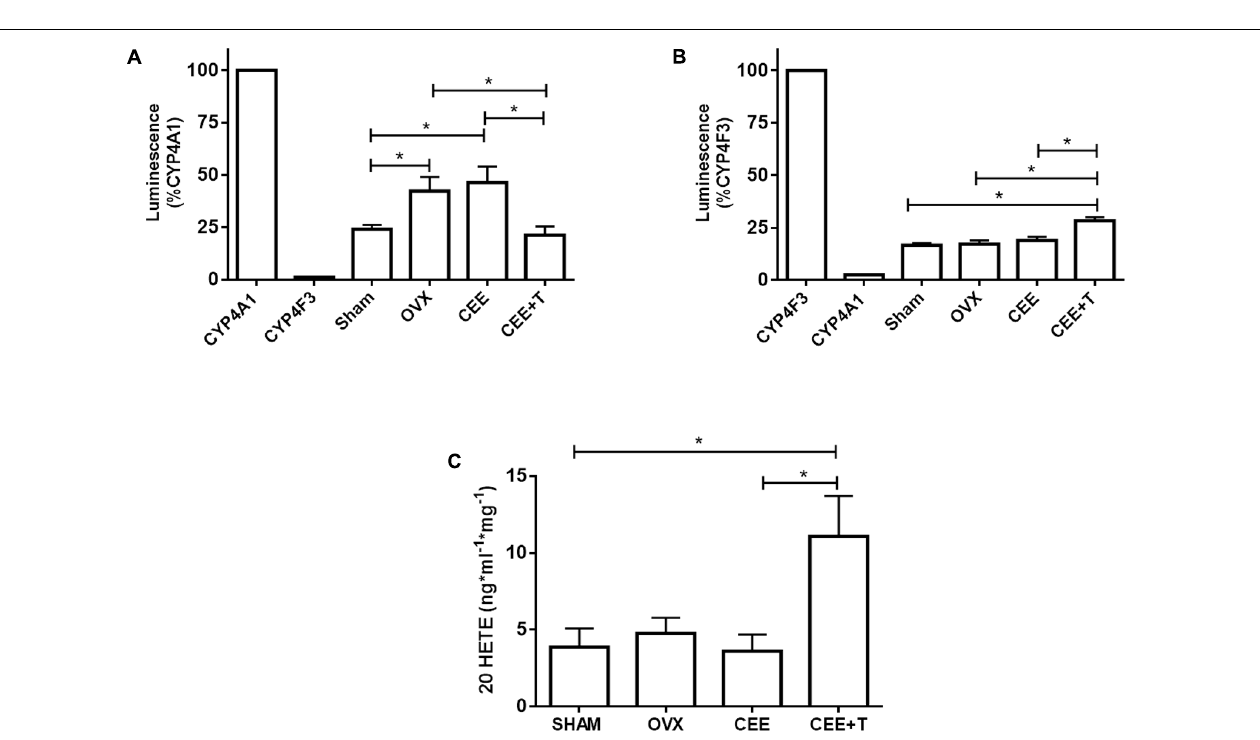
FIGURE 6 | Luminescence induced by CYP4A1 (A) and CYP4F3 (B) substrates, and (C) 20 HETE levels in aorta of SHAM, ovariectomized (OVX), OVX treated with conjugated equine estrogens (CEE) and OVX treated with CEE plus testosterone (CEE+T) female spontaneously hypertensive rats. Enzyme activity is expressed in percentage relative to the luminescence induced by recombinant CYP4A1 or CYP4F3 enzymes. Results represent the mean ± SEM from 3 to 6 independent experiments performed in duplicate. One-way ANOVA: ∗ P <